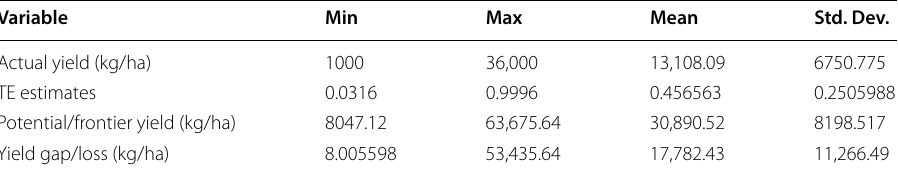
Table 10 Potato yield gap due to technical inefficiency. Source: Computed from Field Survey Data, 2015/16